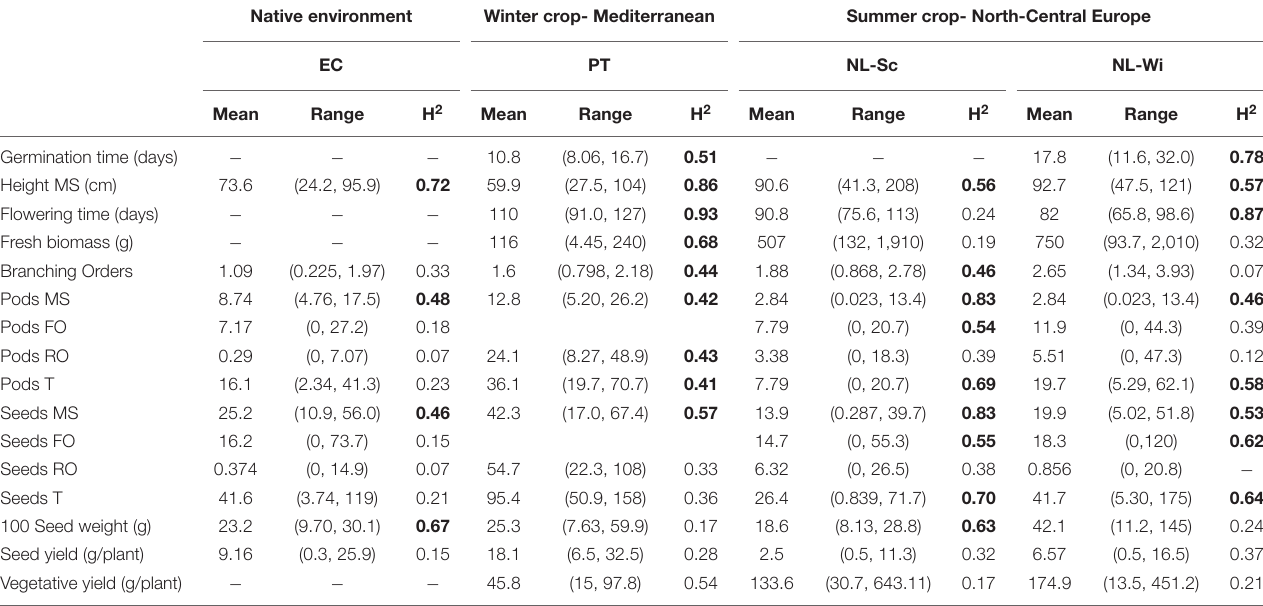
TABLE 2 | Mean, range of variation, and broad-sense heritability (H 2 ) for the BLUEs values of morphological and phenological traits were assessed across the different field